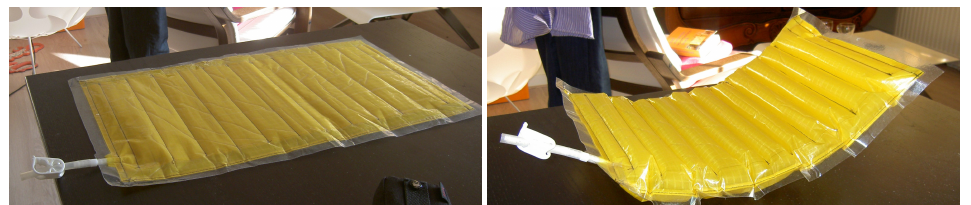
Figure 20. Sewed prototype of a curved woven mattress. This specific sample was not produced by the Jacquard technique, but labor-intensive hand sewing, as its main purpose was to demonstrate that a curved structure can be obtained out of a flat structure under